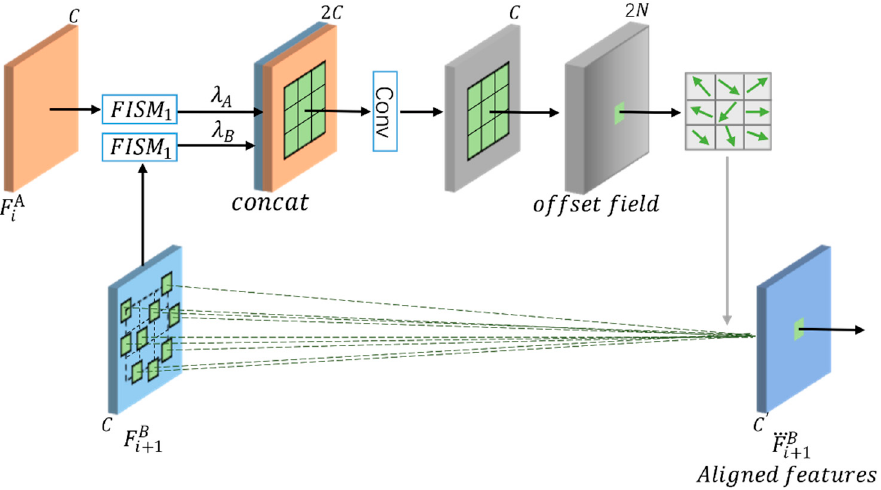
Figure 4. Schematic of offset calculation in FAFM.